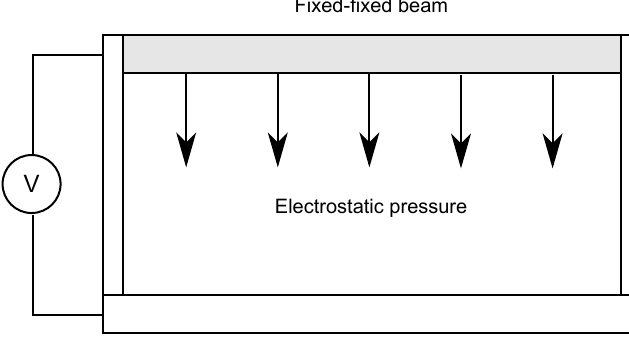
Figure 3. The schematic diagram of the MEMS device—a fixed-fixed beam with an applied voltage V over a ground